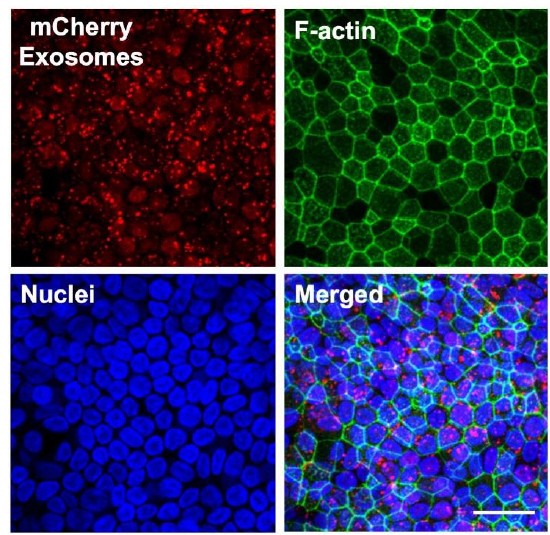
Figure 4. Exosome-mediated protein delivery to well-differentiated HAE. HAE were treated basolaterally for 4 h with exosomes derived from HEK-293T cells that were transfected with a plasmid expressing mCherry protein (red). After 24 h, HAE were fixed, permeabilized, and then stained for F- actin (red) and nuclei (blue). Scale bar = 50